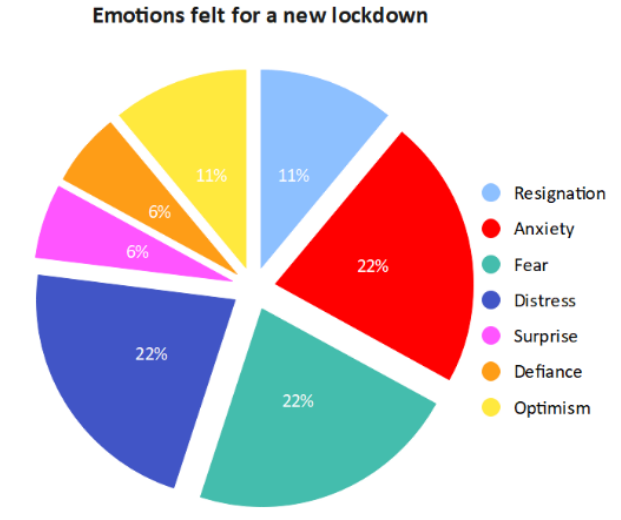
Figure 3. Perceived emotions related to a new lockdown risk.